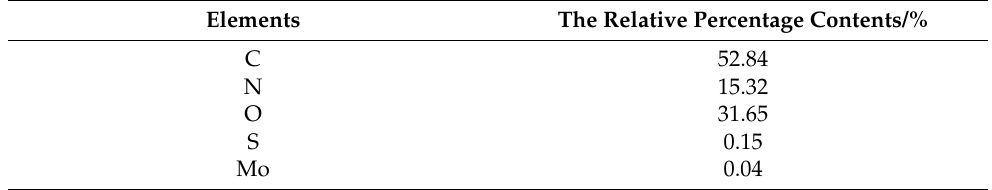
Table 1. Elemental analysis of 2 wt% RSF/MoS 2 NPs hybrid fibers residues after thermal decompo- sition.